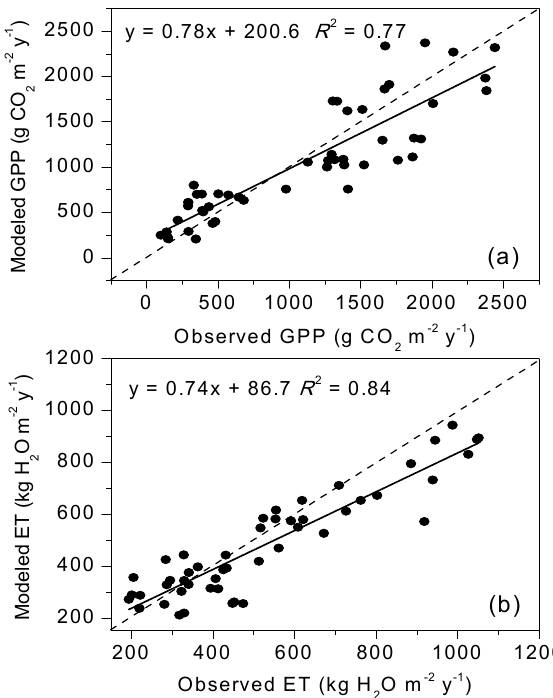
Figure 4. Comparisons of the yearly values of modeled GPP ( a ); and ET ( b ) with observations from EC systems for ecosystems in China ( n = 49). The sites used for model parameterization (Table 1) are not included in the illustration.